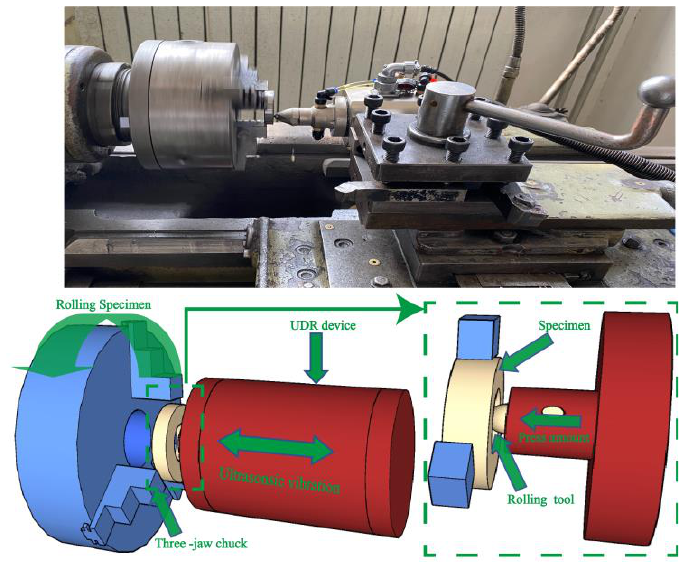
Figure 1. Diagram of the ultrasonic deep rolling